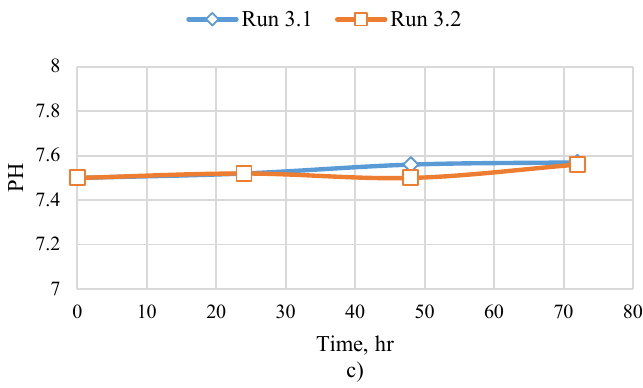
Fig. 3. pH vs time. (a) brewery wastewater and sludge mixture (combination 1); (b) potato wastewater and sludge mixture (combination 2); and (c) potato waste and animal dung mixture (combination